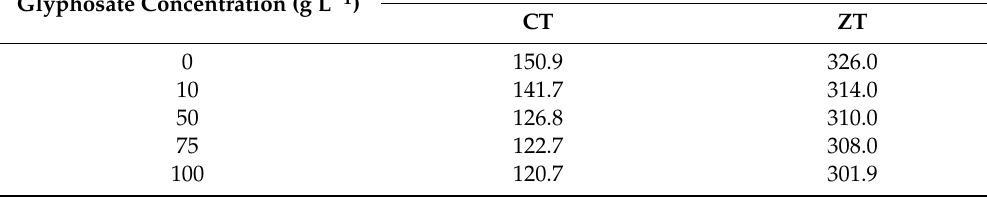
Table 2. Calculated fungal biomass (from Equation (1) [26]) for glyphosate applied soils of CT and ZT treated soils under controlled glasshouse conditions, indicating fungal growth inhibition from glyphosate application above 75g L − 1 over 12